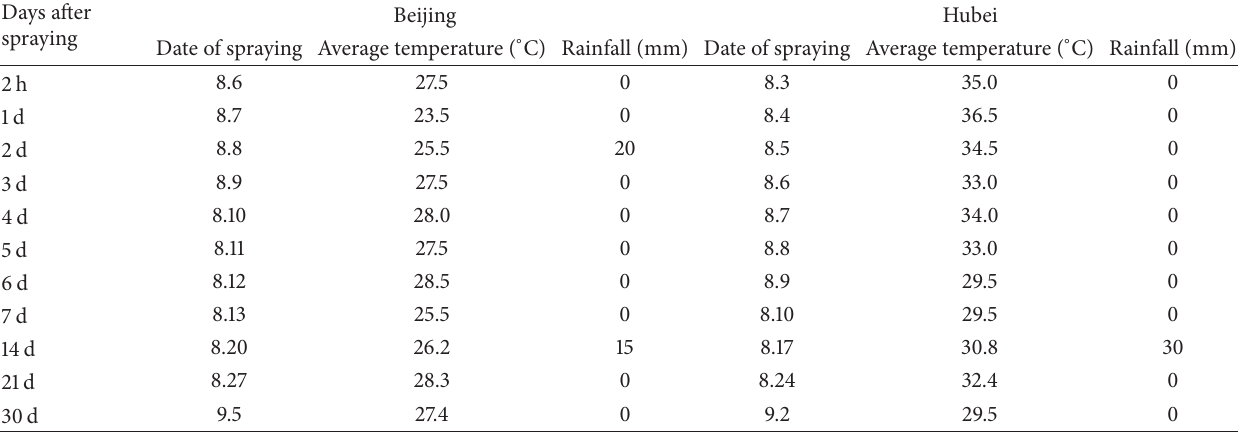
Table 5: The daily average temperature and the rainfall during the dissipation experiment in Beijing and Hubei, China (2014). Days after Beijing Hubei spraying